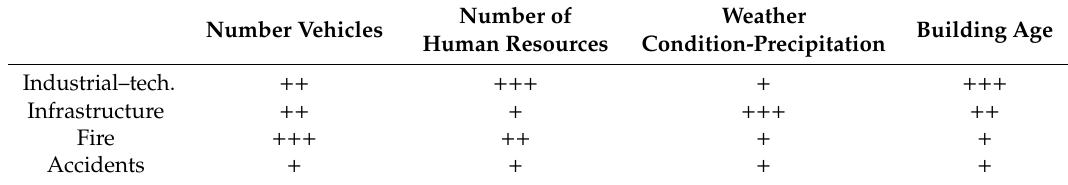
Table 2. Incident type versus variable importance from the data analytics performed, where +++ means higher intensity of occurrences ++ medium intensity of occurrences and + lower intensity of occurrences. Number of Weather Building Age Number Vehicles Human Resources Condition-Precipitation Industrial–tech. ++